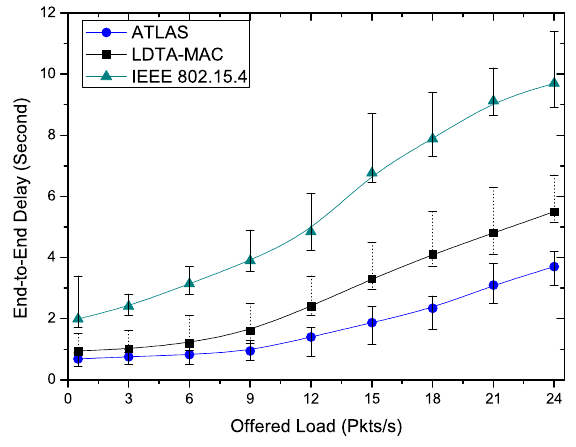
Figure 6. End-to-end delay over diverse traffic